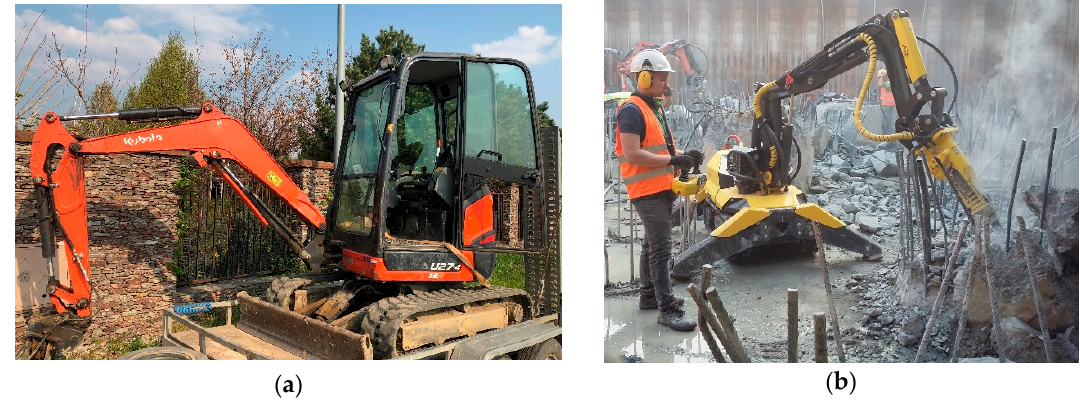
Figure 1. Example of heavy duty machines: ( a ) Mini-digger with operator cabin; ( b ) Remote controlled robot with the operator standing next to the machine.